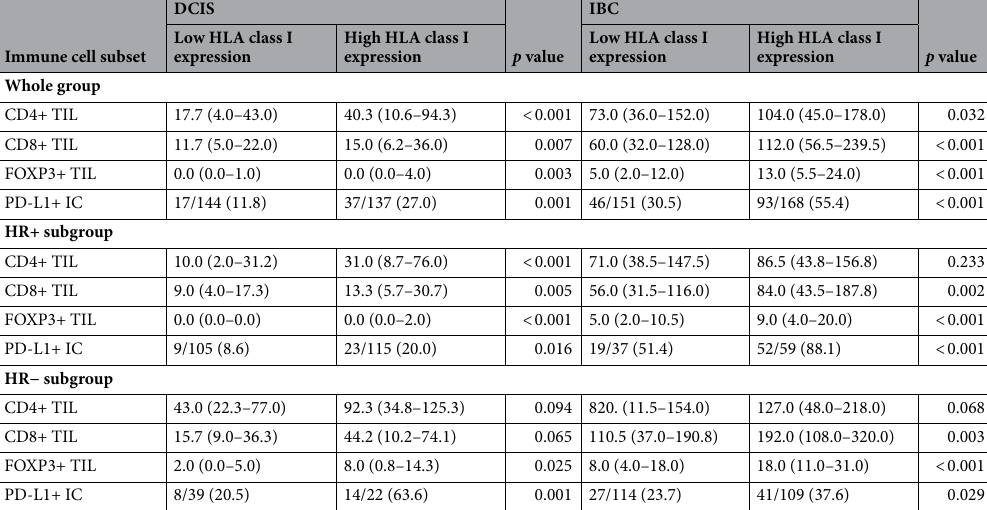
Table 5. Comparison of immune cell subset infiltration in relation to HLA class I expression. p values are calculated by Mann–Whitney U test or Chi-square test. Data are presented as median (interquartile range) for TIL and frequency (%) for PD-L1+ IC. HLA human leukocyte antigen, DCIS ductal carcinoma in situ, IBC invasive breast carcinoma.